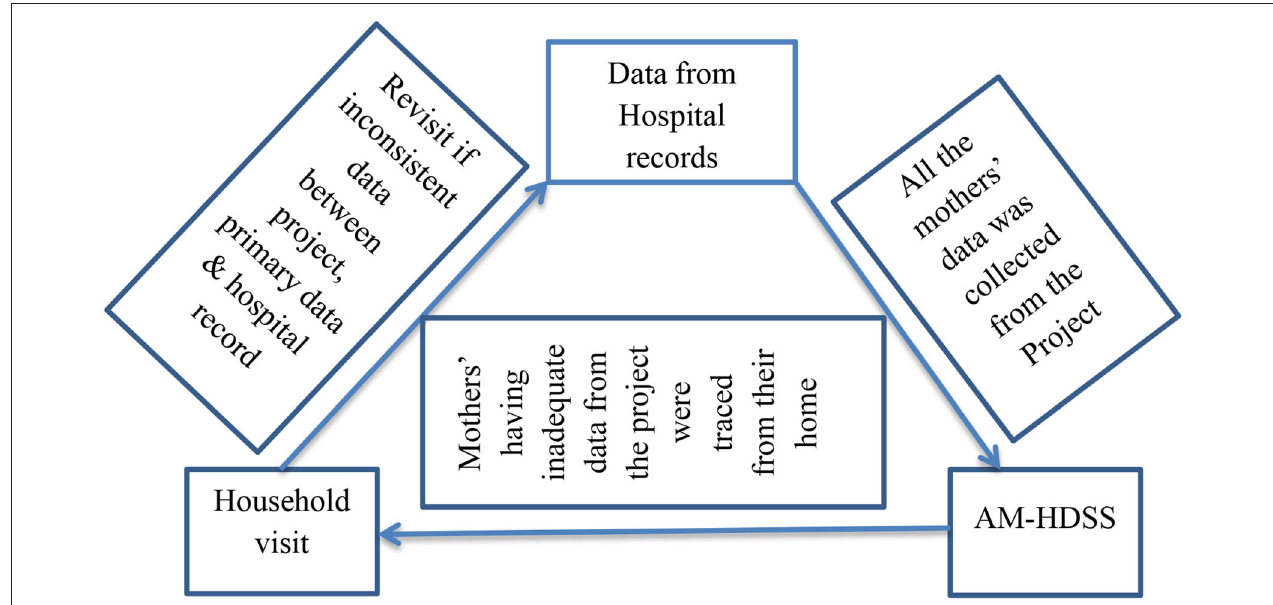
FIGURE 1 | Information flow system framework among ANC attended pregnant mothers at Gamo Zone public